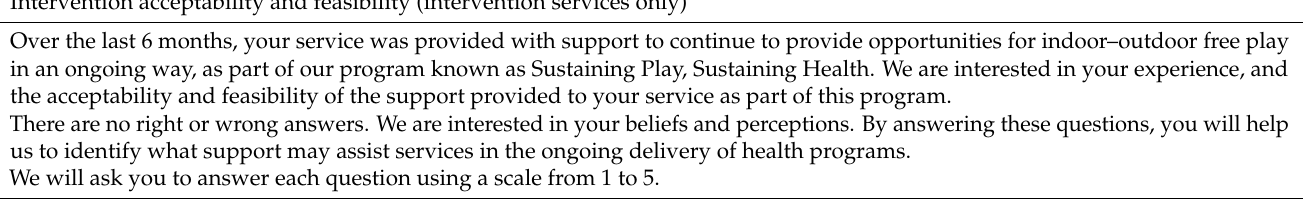
Table 3. Feasibility and Acceptability